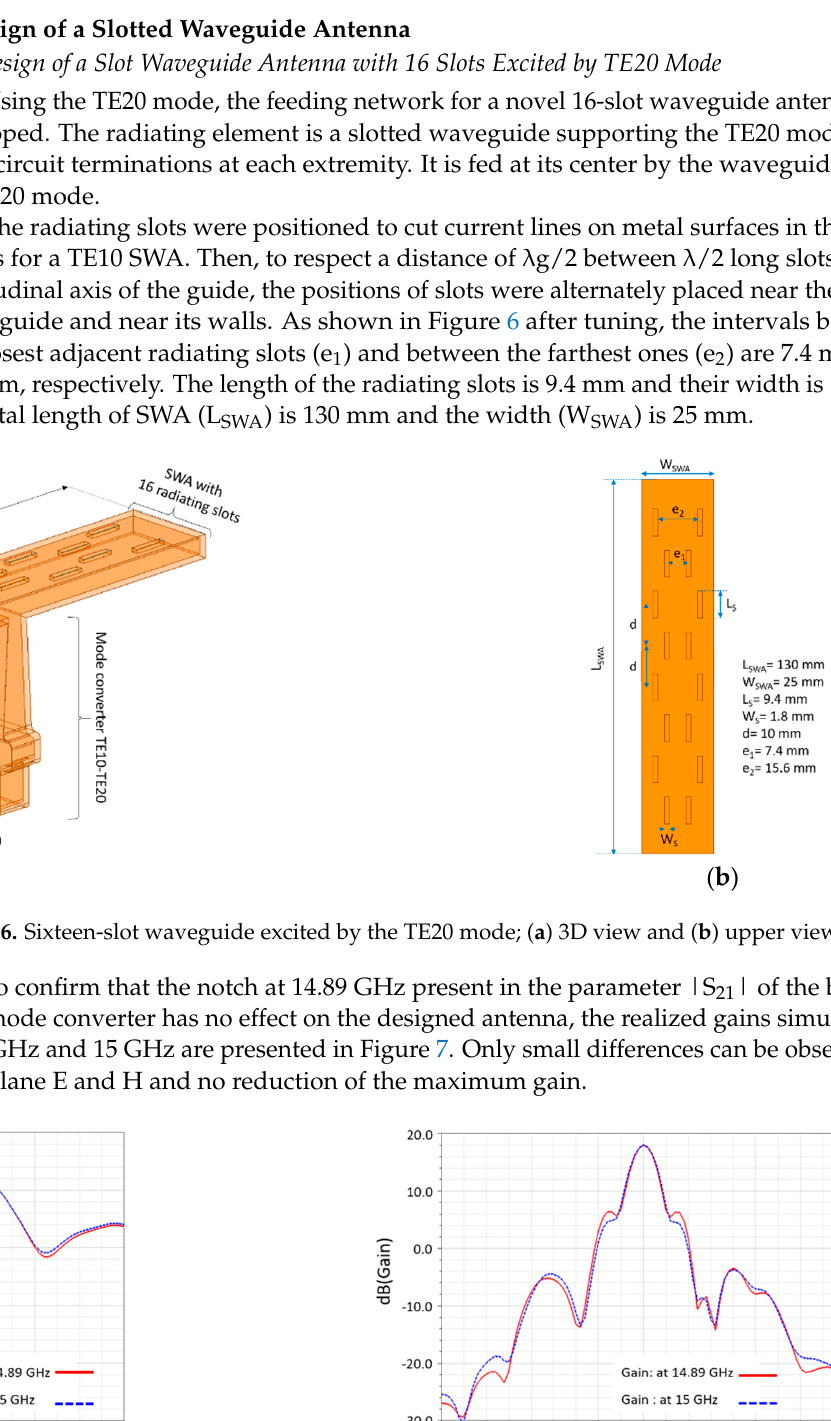
( b ) Figure 5. Electrical field in the back-to-back mode converter at two frequencies; ( a ) at 14.89 GHz and ( b ) at 15 GHz. These results, therefore, prove that the design of the converter and its manufacture